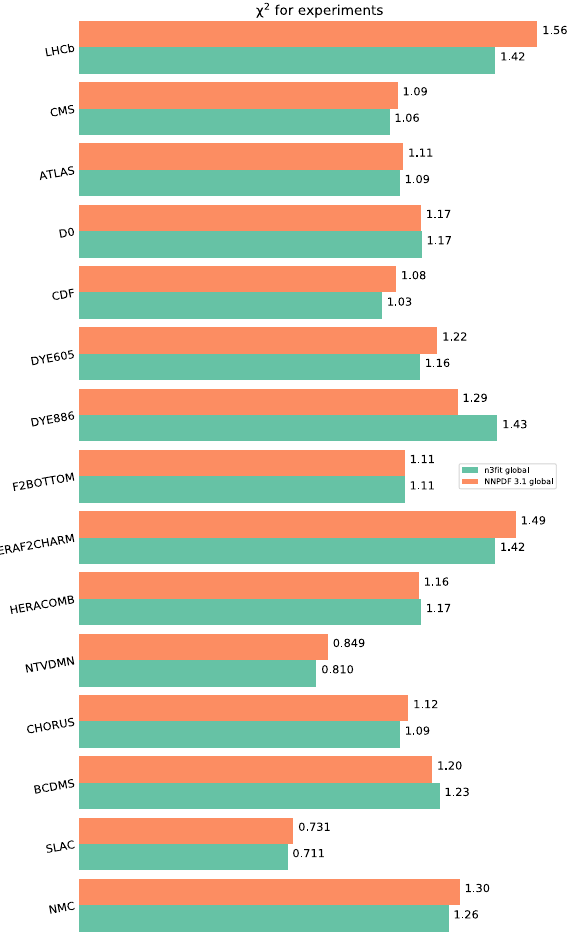
Fig. 8 Comparison of the χ 2 between both the new and old codes experimentbyexperimentforaglobalfit.Anexperimentiscomprisedof oneormoredatasetsofexperimentaldata.Wefindthenewmethodology to be able to produce fits with a quality similar to the old methodology for every experiment